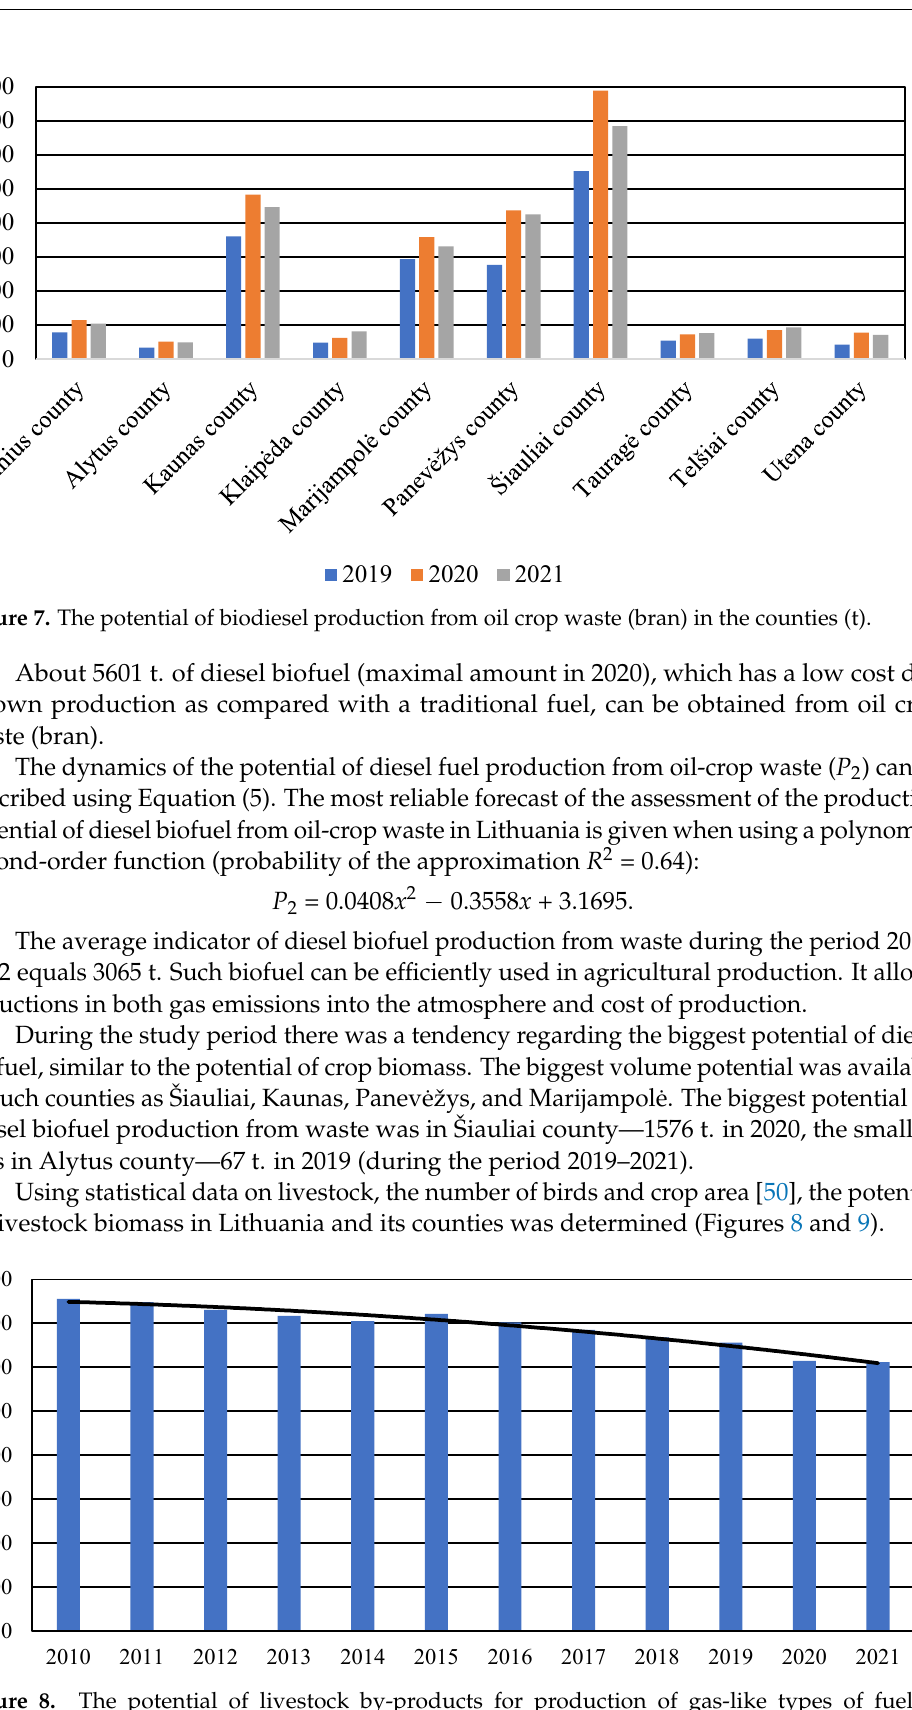
Figure 6. The potential of biodiesel production from oil ‐ crop waste (bran) in Lithuania (thous. t.).